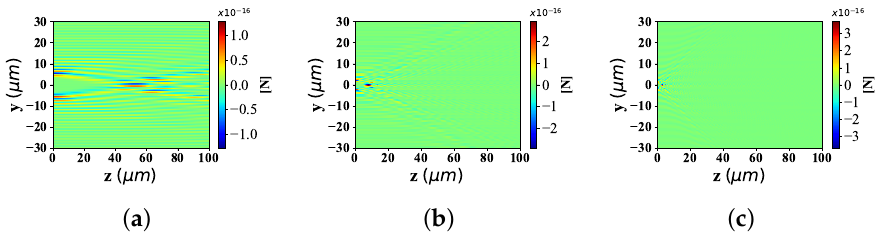
Figure 6. Distribution of F y under the interaction between the sphere and Bessel pincer light-sheets beam with different beam scaling parameter α 0 ( α 0 = 0.2, 0.5, and 0.8; beam order is l = 10). ( a ) α 0 = 0.2; ( b ) α 0 = 0.5; ( c ) α 0 = 0.8.